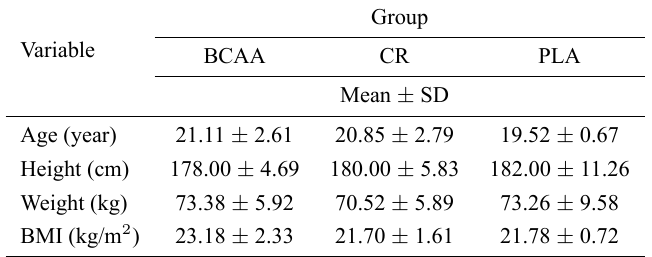
Table 1. Descriptive statistics for